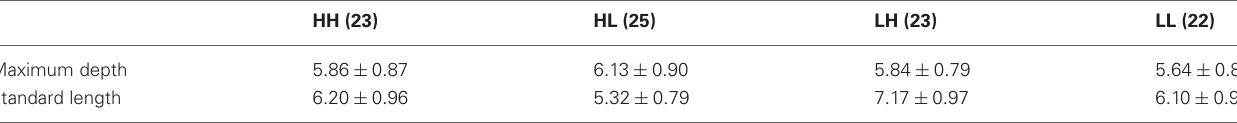
The first letter represents the food rations for days 0–30 (high vs low). The second letter represents the food rations for days 30–60 (high vs low). The number represents the sample size for each treatment. Data are presented as untransformed arithmetic mean ± SEM.